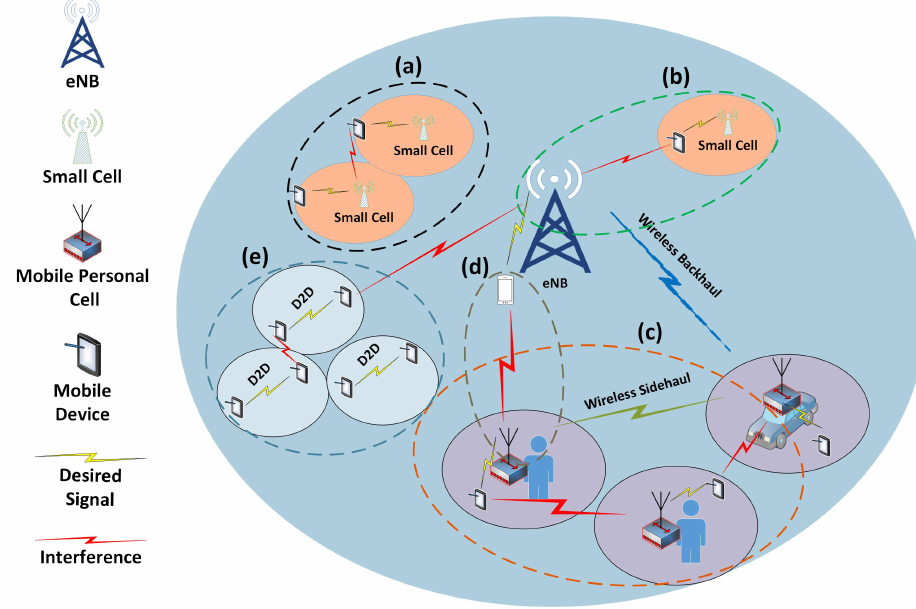
Figure 2. Illustration of various kinds of inter-cell interference after mPC deployment in a